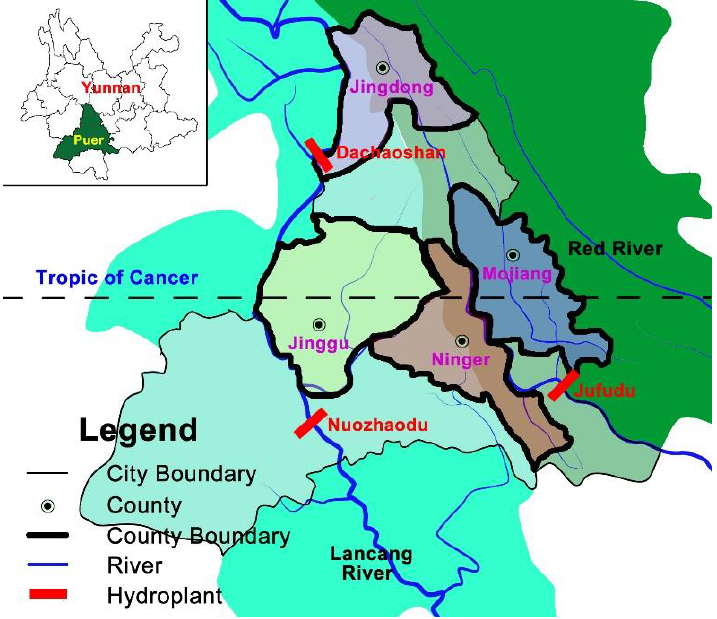
Figure 6. Map of typical basins, counties and LHP plants in Puer